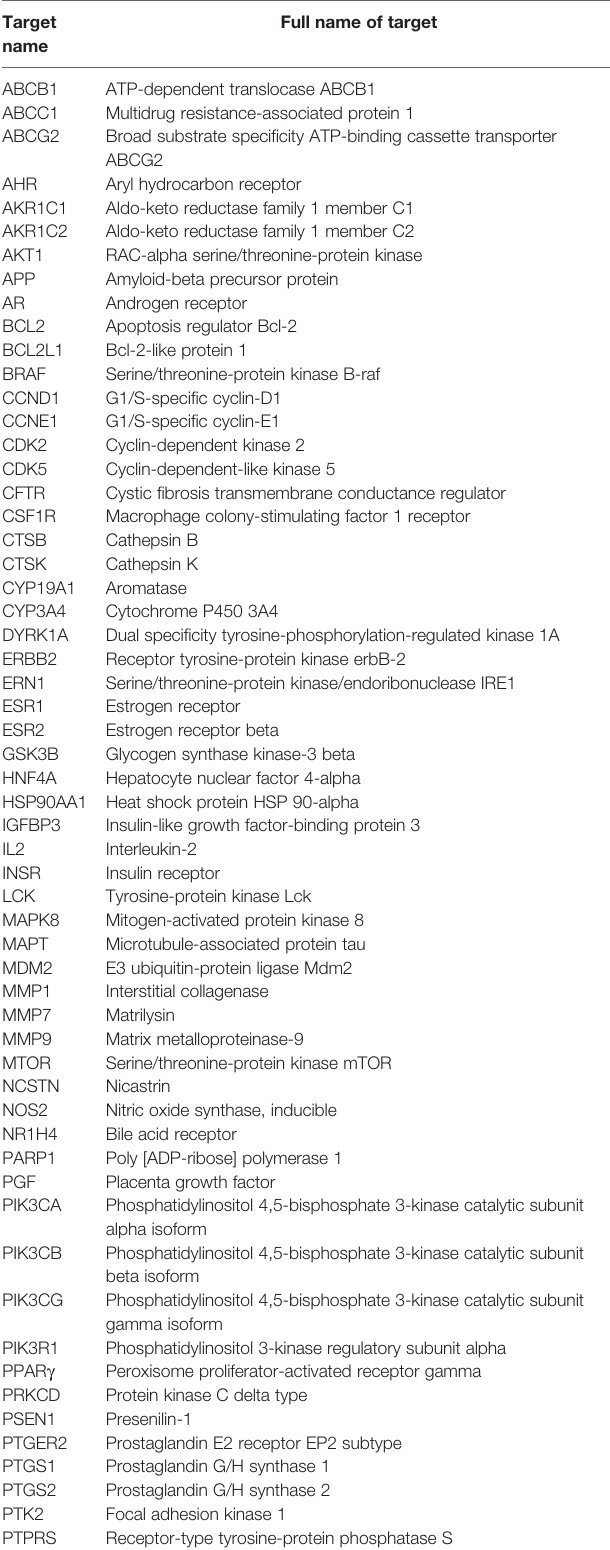
TABLE 2 | The information of 67 overlapped